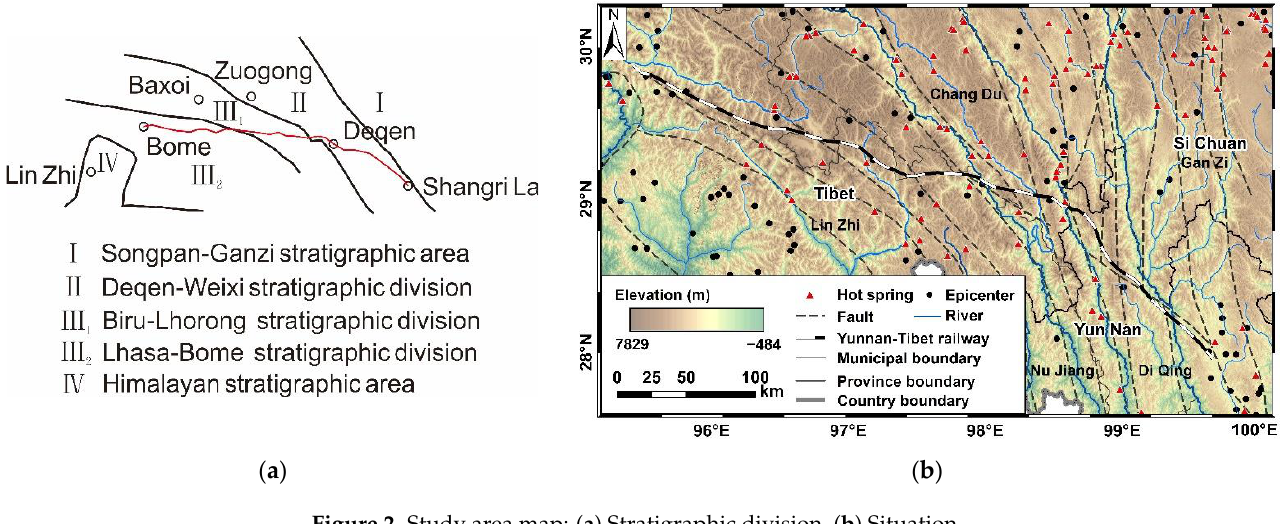
Figure 2. Study area map: ( a ) Stratigraphic division, ( b ) Situation. The railway runs through the Yunnan–Tibet geothermal zone in the great bend